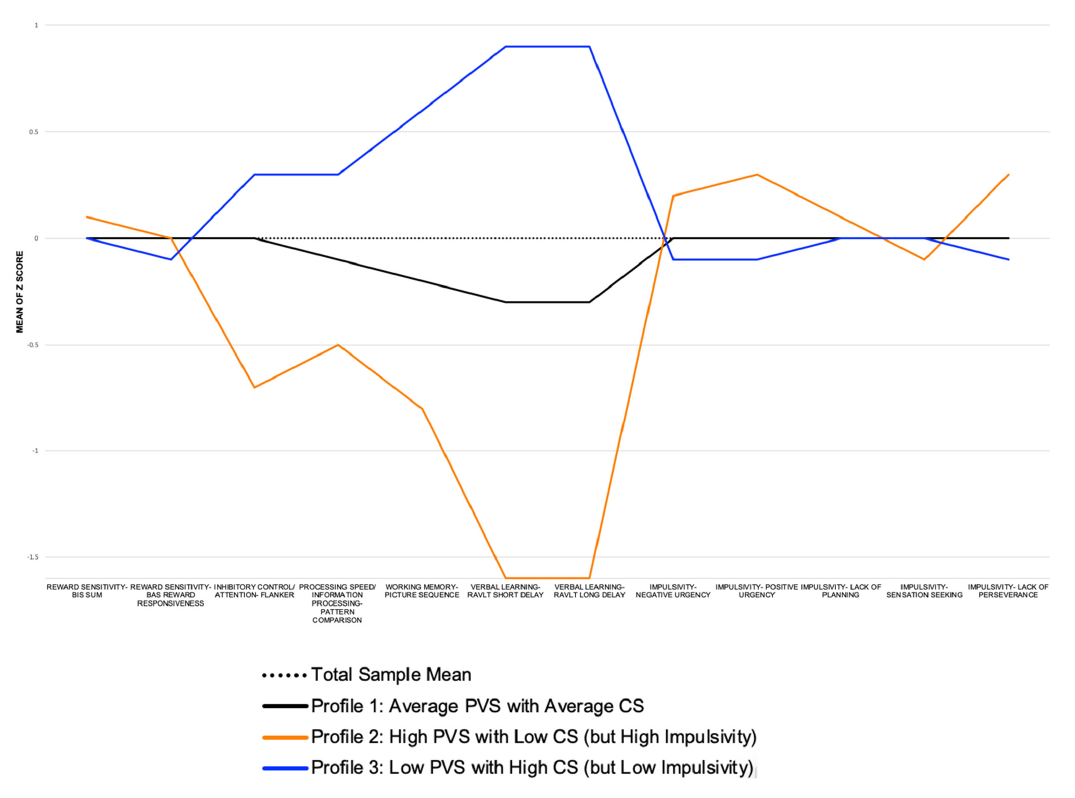
Figure 1. Positive valence and cognitive system domains (X Axis) and mean score (Y Axis) by profile at baseline enrollment in the Adolescent Brain and Cognitive Development study ( N = 10,414).